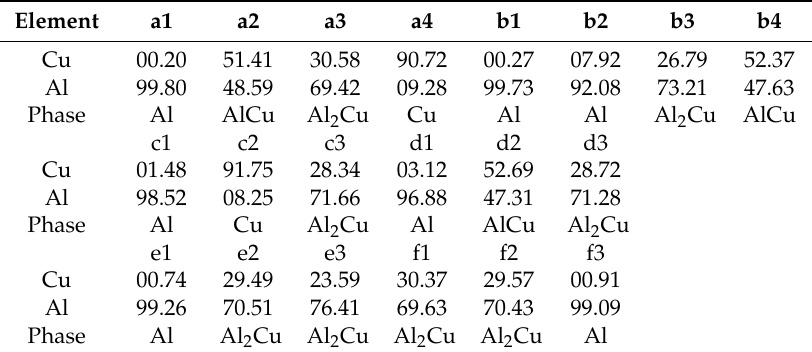
Figure 11. Peeled surface morphology (BSE image) of the Cu/Al clad sheets with thicknesses of 7 mm after multi-pass rolling and annealing ( a , b ), 5 mm ( c , d ) and 3 mm ( e , f ). ( a , c , e : Cu side; b , d , f : Al side). Table 7. The EDS results of the peeled surfaces in Figure 11 (at.%).